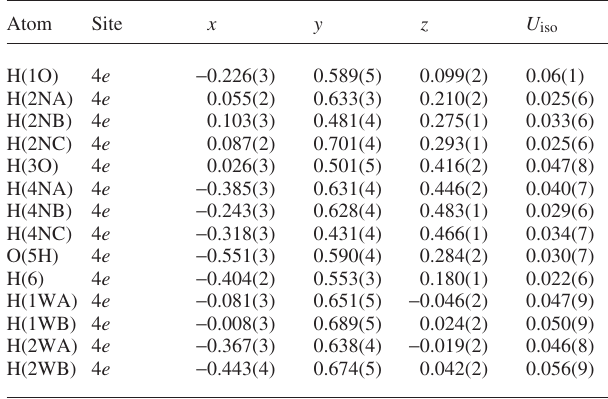
Table 2. Atomic coordinates and displacement parameters (in Å 2 )